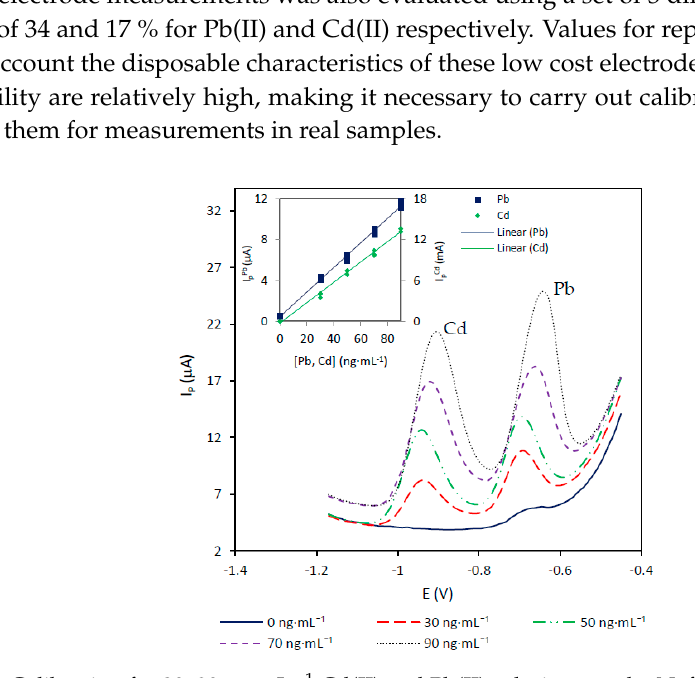
Figure 9. Calibration for 30–90 ng · mL − 1 Cd(II) and Pb(II) solutions on the Nafion-protected Bi SP SPE in 0.05 M pH 4.4 acetate buffer. Experimental conditions: Deposition time: 120 s; deposition potential: − 1.2 V; stirring rate: 600 r.p.m.; cleaning step: 15 s at − 0.45 V; SWV settings: Step potential: 15 mV; frequency: 25 Hz; amplitude 25 mV; initial potential: − 1.2 V and final potential − 0.45 V. Table 1. Calibration data for the determination of Cd(II) and Pb(II) on a Bi SP SPE in 0.05 M pH 4.4 acetate buffer.